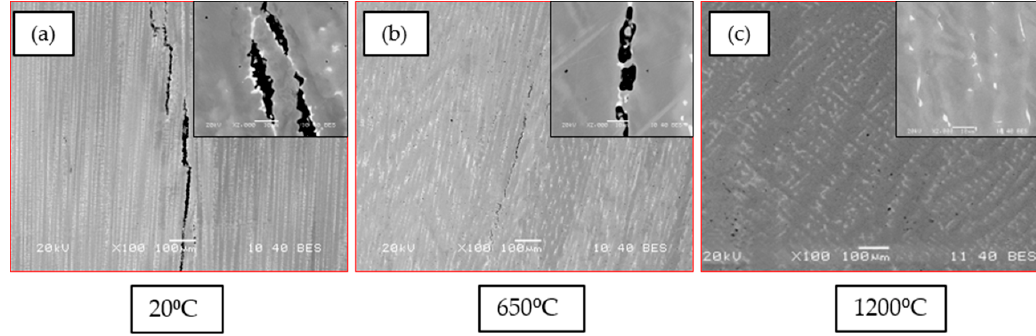
Figure 12. SEM analysis on the facture sections of the WAAM samples at various temperature ( a ) Room temperature 20 °Ϲ ; ( b ) 650 °Ϲ ; ( c ) 1200 °Ϲ .